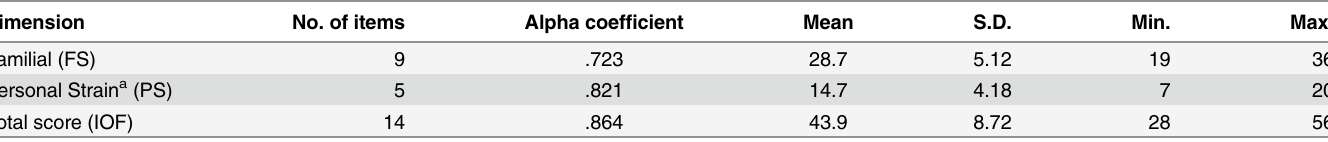
Table 3. Impact on Family.